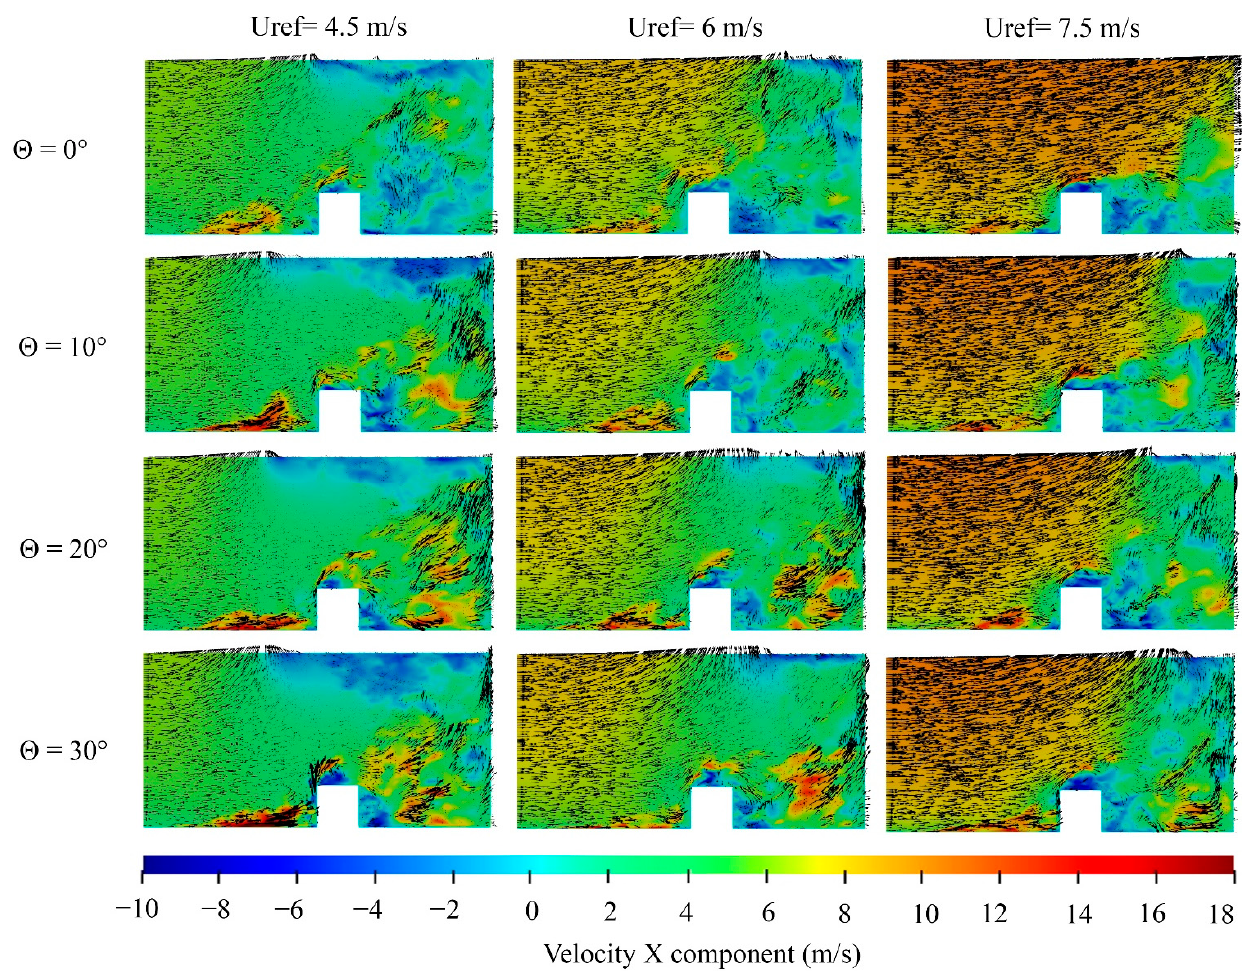
Figure 6. Vertical transects of instantaneous streamwise velocity component (Ux) for the reference velocities U ref = 4.5, 6, and 7.5 m/s in various terrain angle.